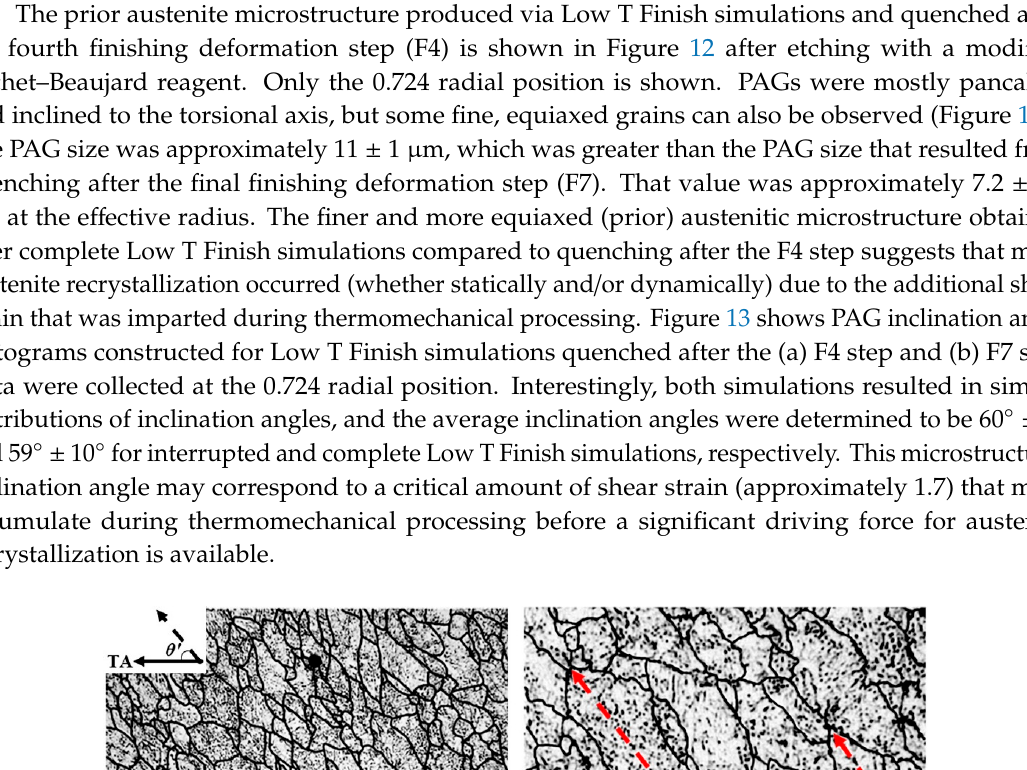
Figure 11. Prior austenite grain ( a ) size and ( b ) aspect ratio with respect to radial position determined for microstructures produced via High T Finish and Low T Finish simulations. The error bars represent one standard deviation.